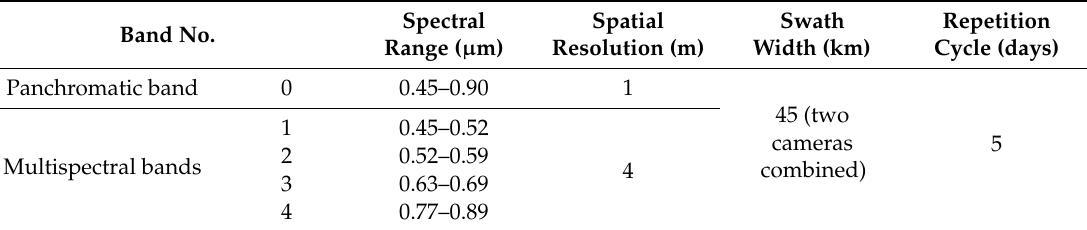
Table 1. Sensors’ technical specifications of the GF-2